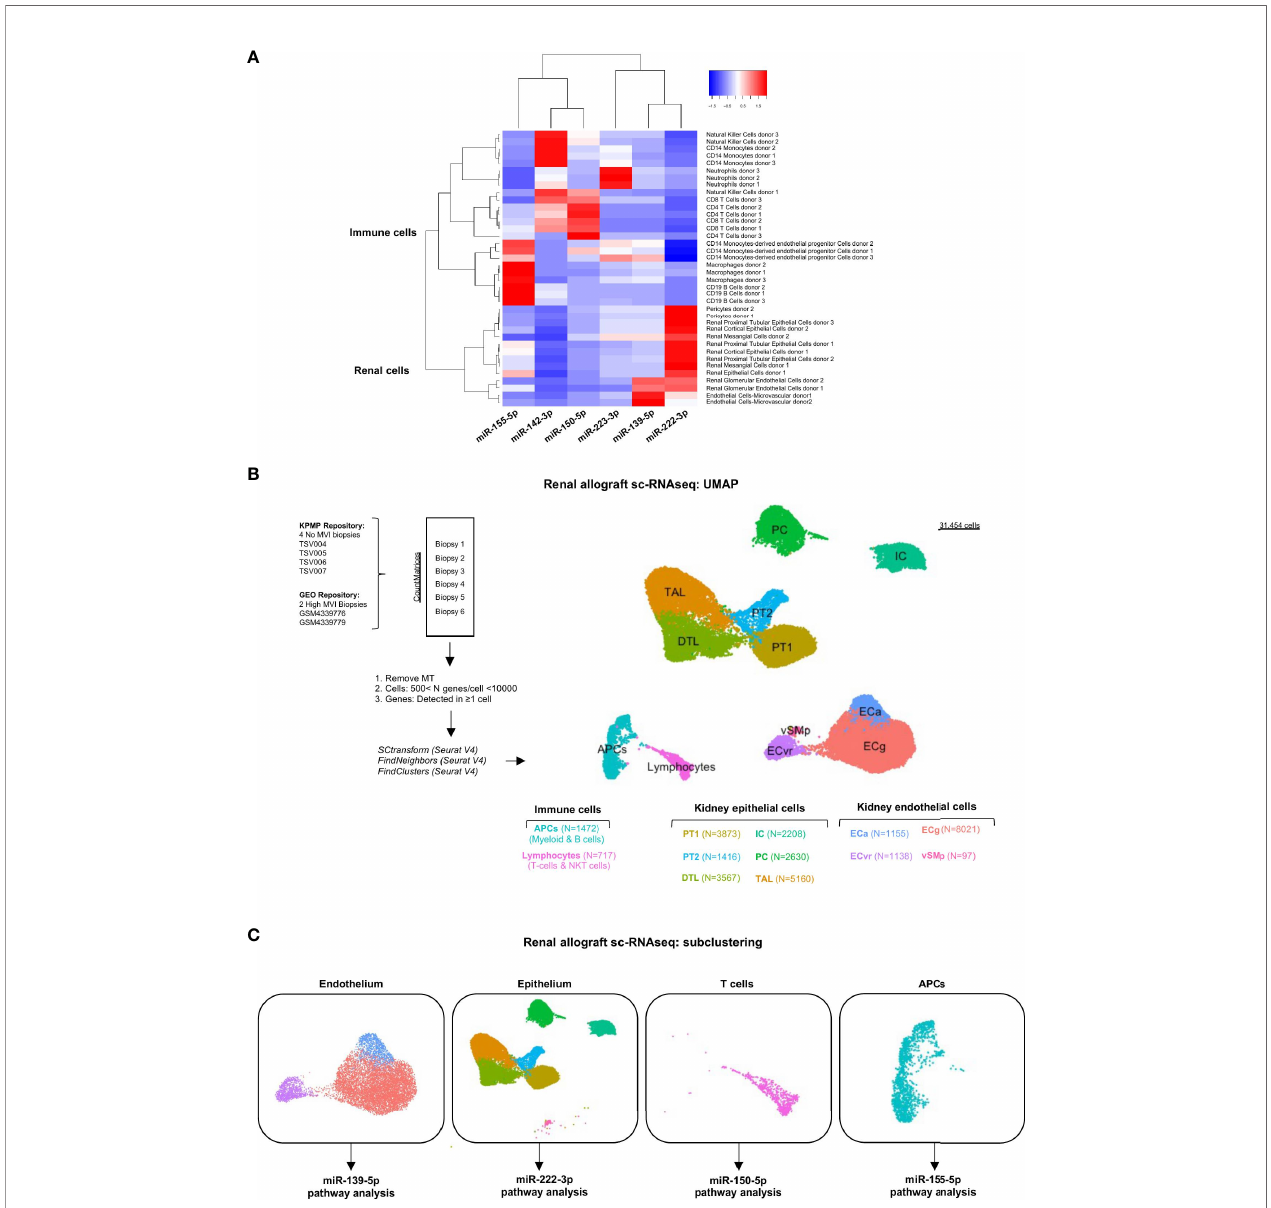
FIGURE 4 | Cellular origins of each individual MVI-associated miRNAs. (A) Heatmap analysis of miRNAs expression across tissues using the Fantom5 project (21). Reordering of dendrograms based on hierarchical clustering. Two distinct clusters, immune-derived and renal-derived miRNAs can be distinguished. (B) UMAP dimensionality reduction of the different cell type clusters from sc-RNAseq analysis of indicated samples: two High MVI biopsies and four No MVI biopsies. The number of cells in each cluster is provided. (C) UMAPs of the four different subclusters corresponding to endothelium, epithelium, T cells and APCs. APCs, antigen- presenting cells; DTL, descending thick limb cells; ECa, activated endothelial cells; ECg, glomerular endothelial cells; ECvr, vasa recta endothelial cells; IC, intercalated cells; PC, principal cells; PT, proximal tubular cells; TAL, thick ascending limb cells; UMAP, Uniform manifold approximation and projection; vSMp, vascular smooth muscle and